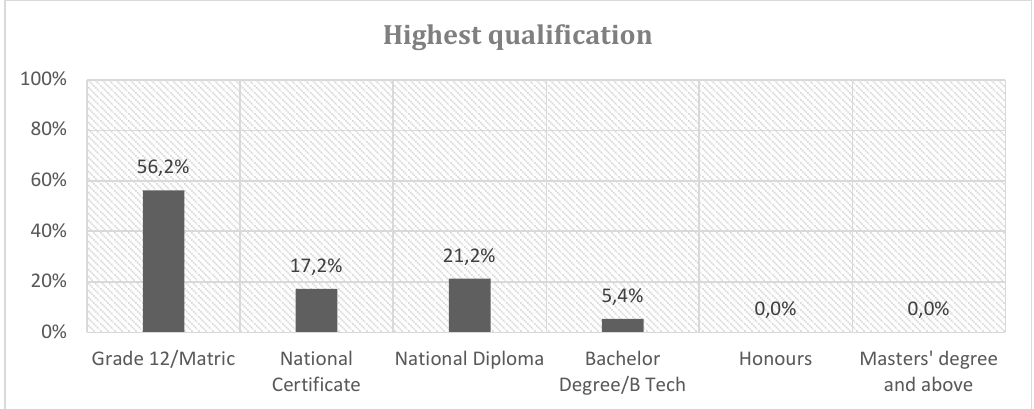
Figure 2. Highest qualification of these police officers